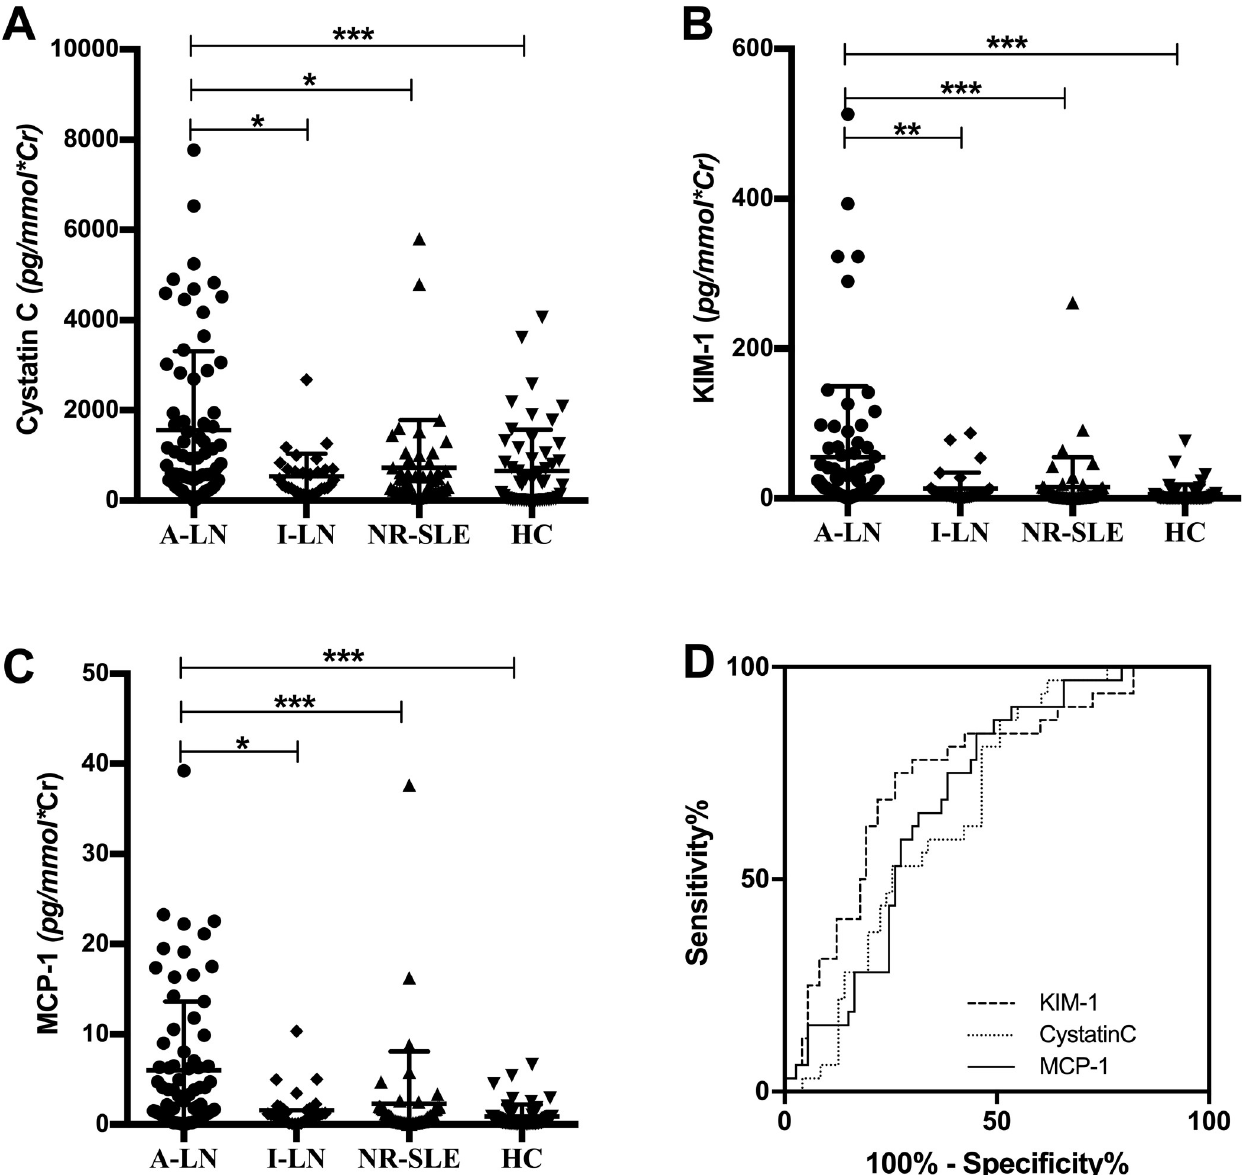
Fig 1. Comparison of three urinary markers in LN patients and healthy controls. Comparison of uCystatinC (A), uKIM-1(B), and uMCP-1(C) levels in four groups of patients showed significant increase of the urinary markers in active LN patients. ROC curve for the three UBMs showed good performance to differentiate active LN from inactive LN (D). A-LN: active lupus nephritis, I-LN: inactive lupus nephritis, NR-SLE: nonrenal SLE, HC: healthy controls, KIM-1: kidney injury molecule 1, MCP-1: monocyte chemoattractant protein 1.